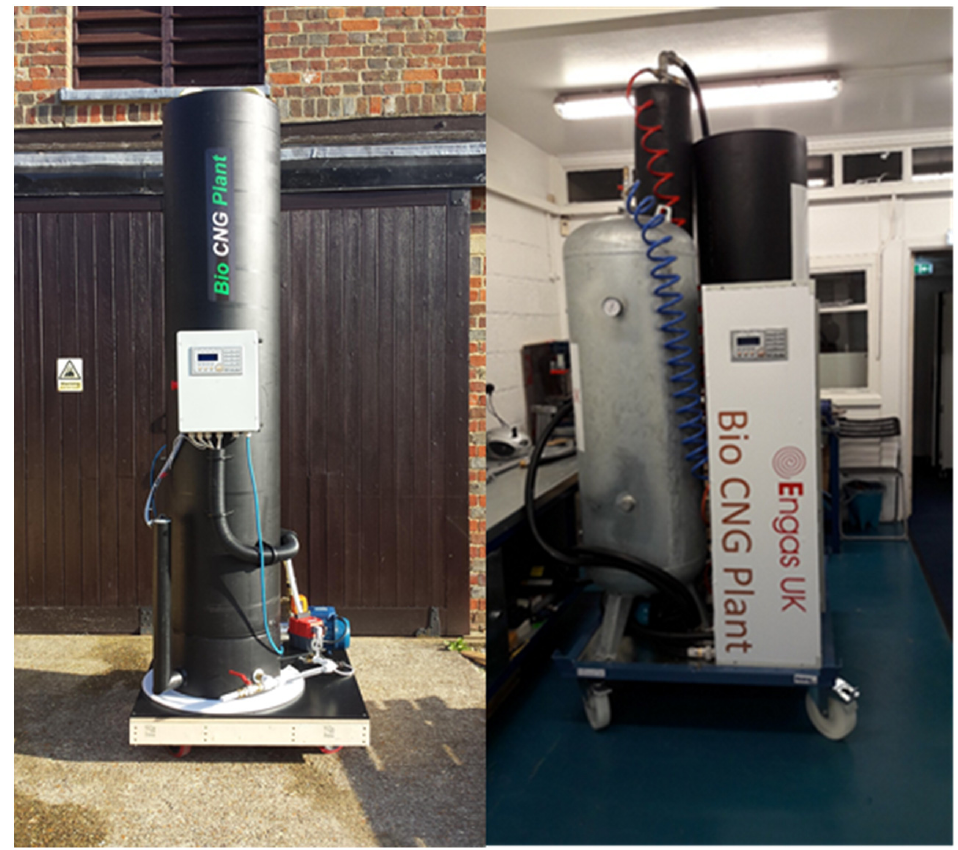
Figure 2. Engas UK’s bioCNG plant.